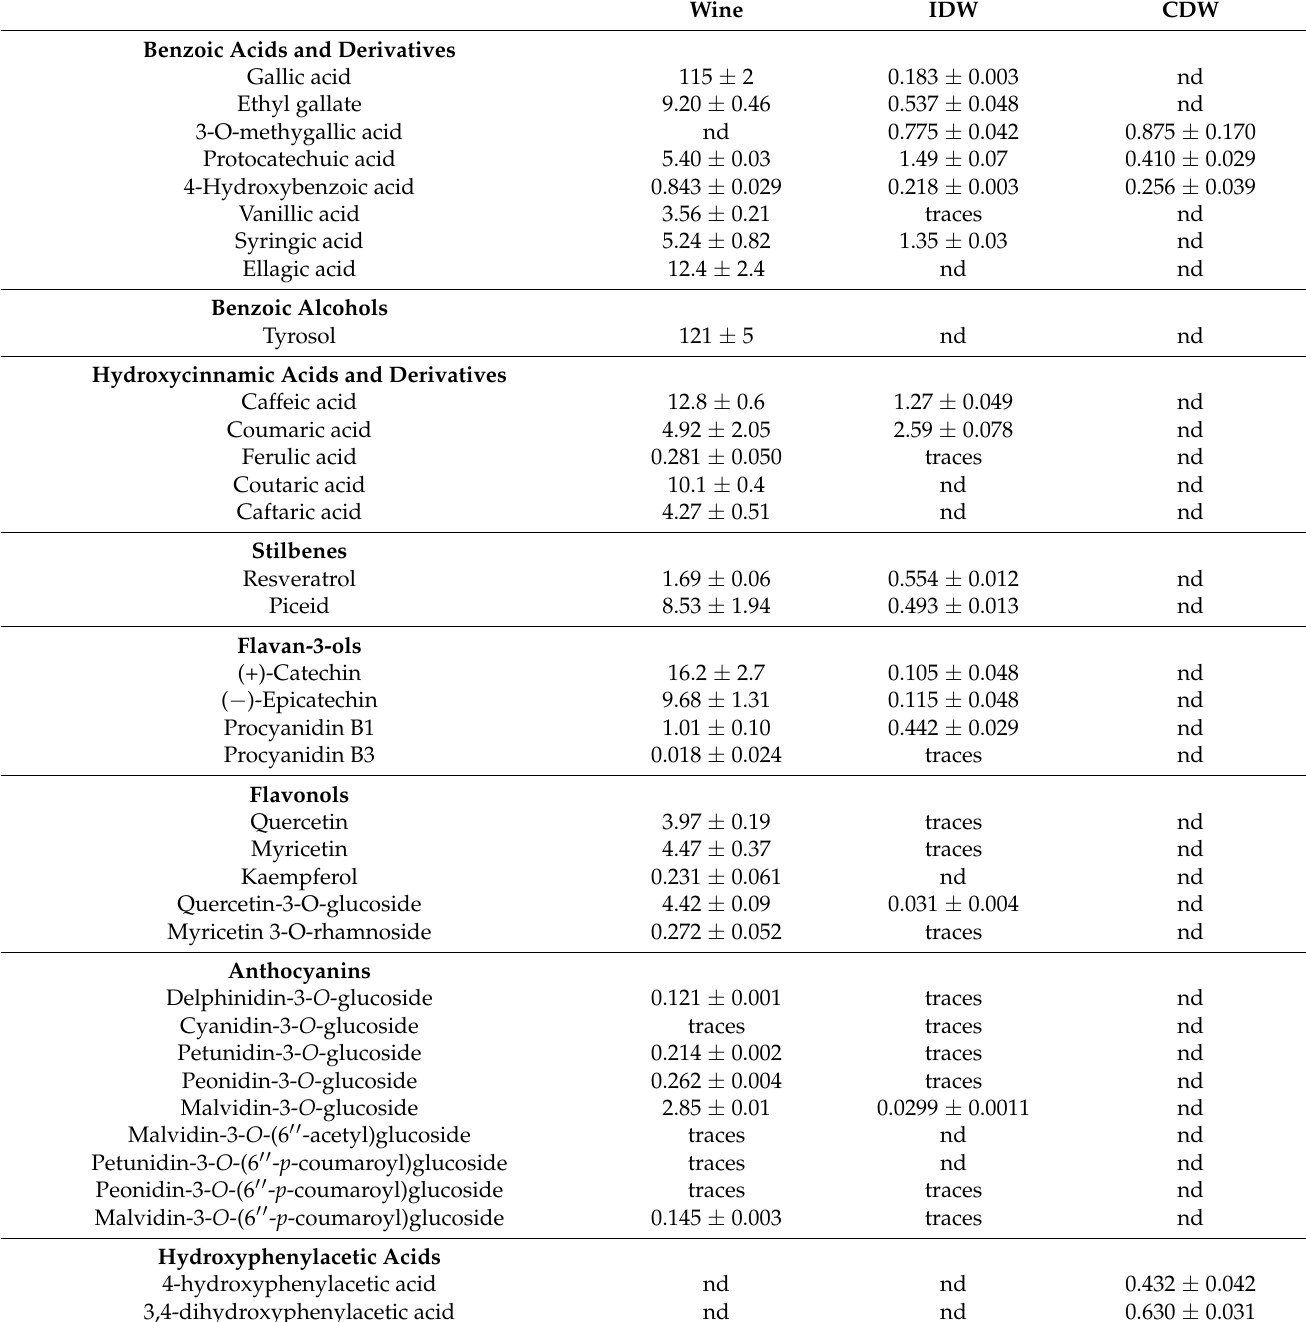
Table 1. Concentration of phenolic compounds (mg/L) in the wine and its intestinal-digested (IDW) and colon-digested (CDW)